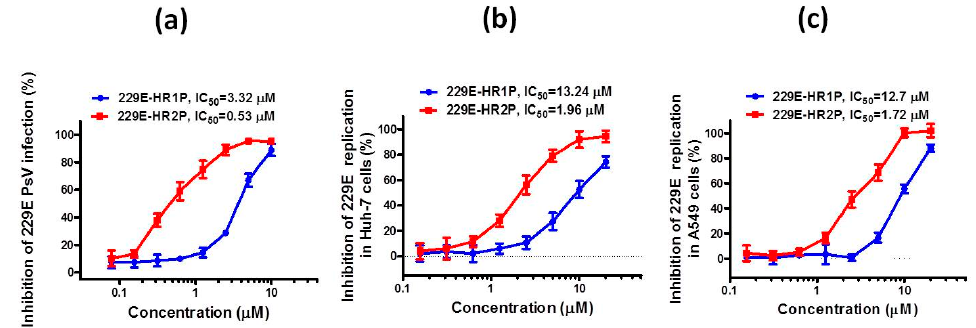
Figure 5. Inhibitory activity of 229E-HR1P and 229E-HR2P against pseudotyped and live HCoV-229E infection. ( a ) 229E-HR1P- and 229E-HR2P-HCoV-229E pseudovirus (PsV) infection in Huh-7 cells; ( b ) 229E-HR1P- and 229E-HR2P-mediated inhibition of HCoV-229E infection and replication in Huh-7 cells; ( c ) 229E-HR1P- and 229E-HR2P-mediated inhibition of HCoV-229E infection and replication in A549 cells. Data are means ± SD of triplicate samples from a representative experiment.